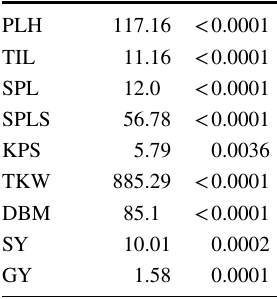
Table 3 ANOVA data of bagasse ash treated durum wheat agronomic parameters and yield and yield